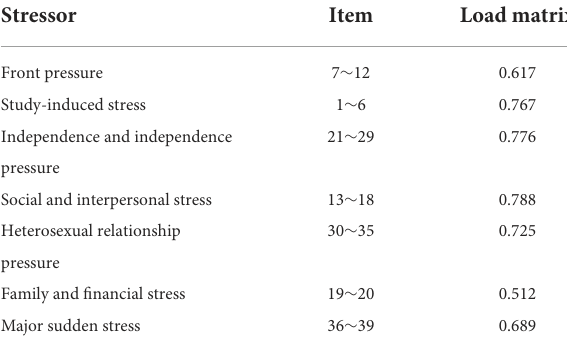
TABLE 3 Factor loading